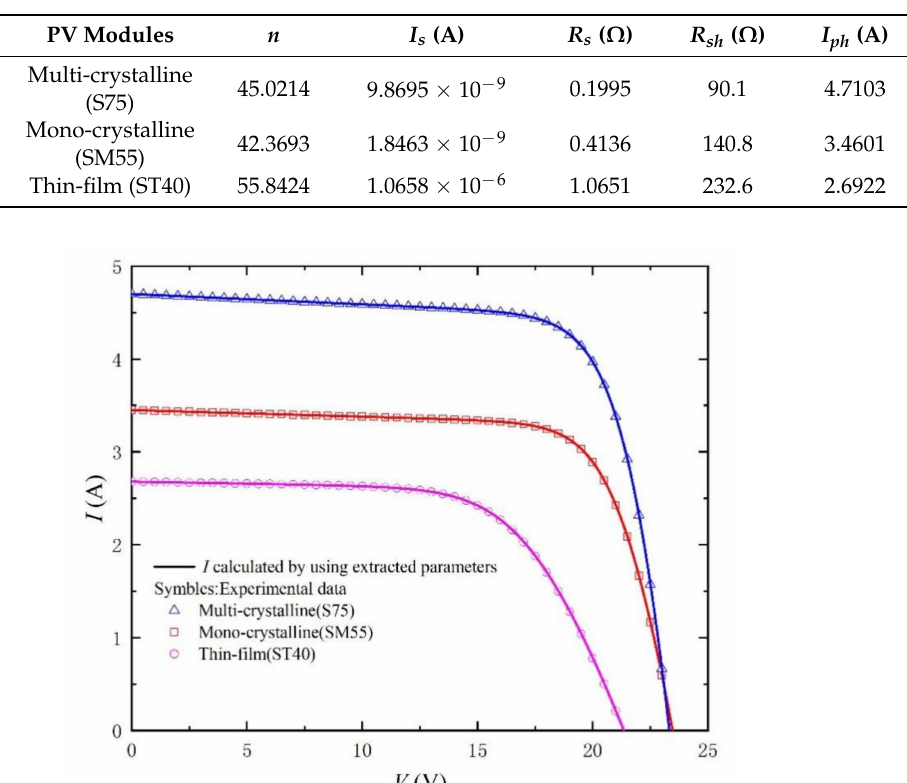
Table 2. Parameter-extraction results and RMSE for I- and P-V Curves in Figures 6 and 7.